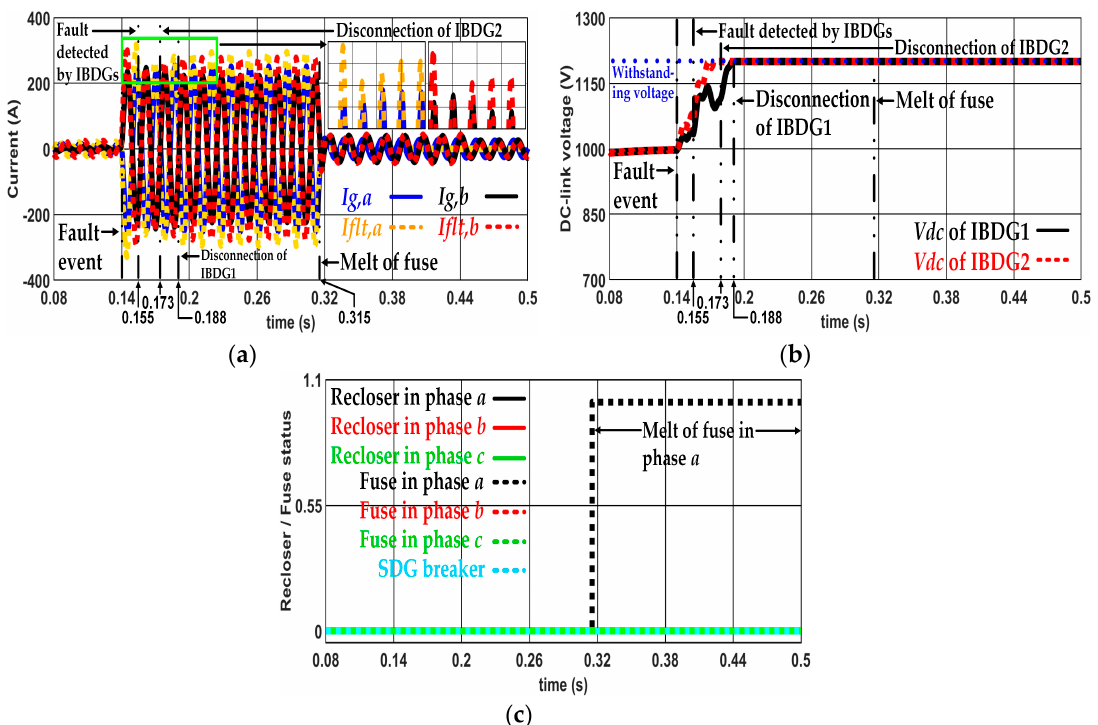
Figure 14. Conventional current control during temporary LL fault: ( a ) total fault current and grid current; ( b ) DC-link voltage; ( c ) operating time of recloser–fuse and SDG breaker.